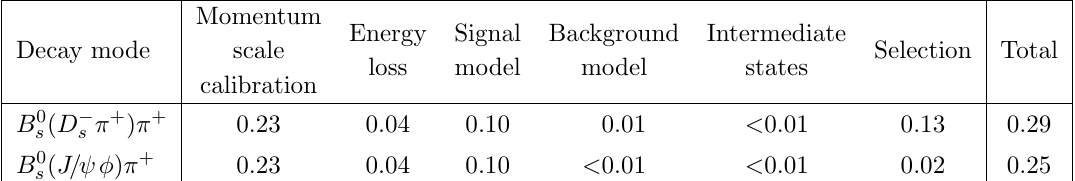
Table 4. Summary of systematic uncertainties on the mass di(cid:11)erence (cid:1) M (in MeV =c 2 ) for the B 0 ( D (cid:0) (cid:25) + ) (cid:25) + and B 0 ( J= (cid:30) ) (cid:25) + decays. s s s